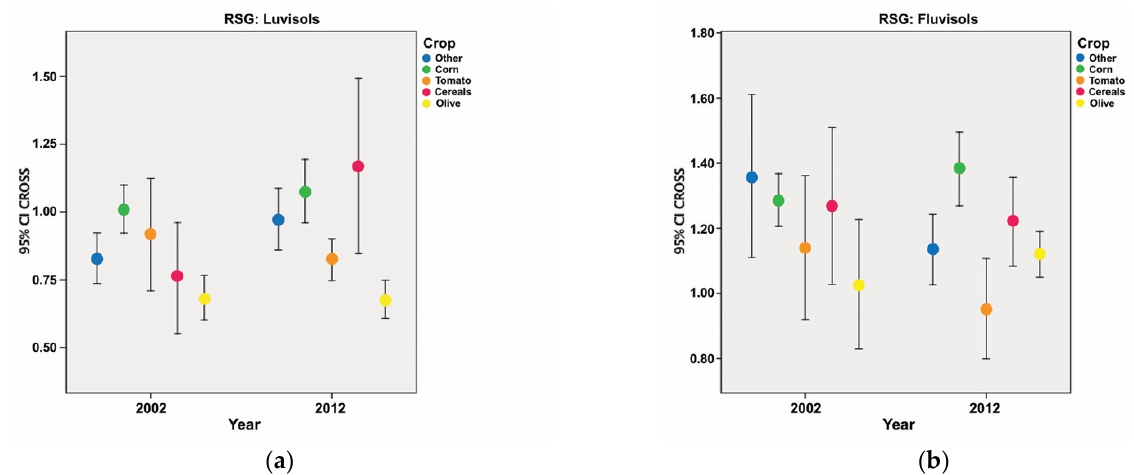
Figure 8. CROSS mean bars comparison by sample data (2002 and 2012) in ( a ) Luvisols x crop and ( b ) Fluvisols x crop.